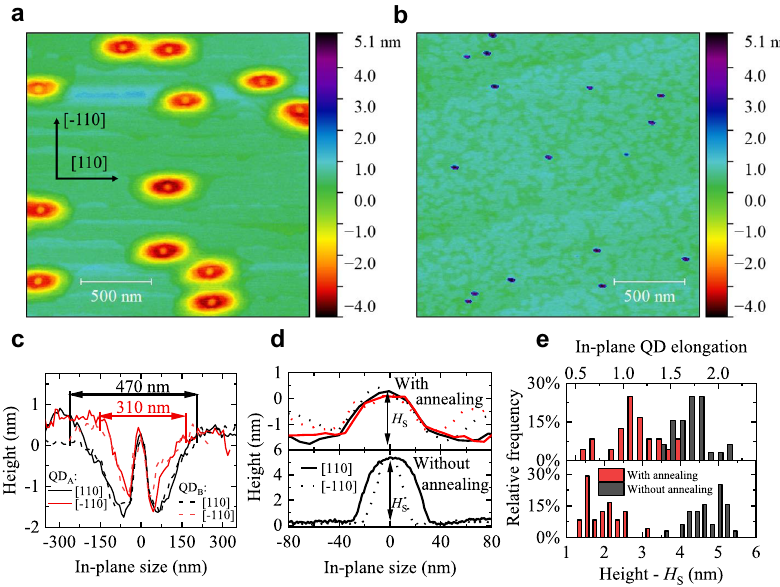
Figure 1: Morphological investigation of sur- face DE QDs by atomic force microscopy, (2 × 2) μ m 2 scans. (a) Annealed QDs in etched pits. (b) QDs before annealing. (c) Cross-section scans of QDs and the pits around annealed QDs. (d) Comparison of the QD cross-sections: after annealing [top panel, close-up of (c)] and before annealing (bottom). (e) Statistics of the QD in-plane elongation (top) and height